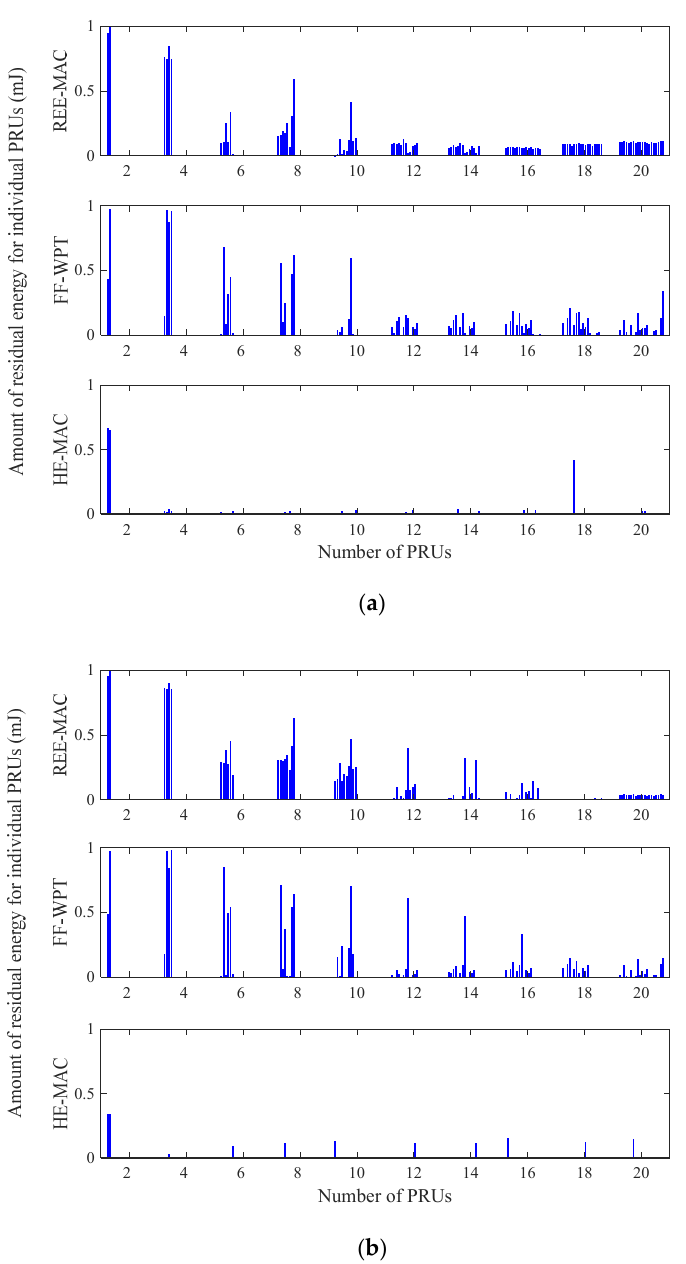
Figure 8. Residual energy distribution of individual PRUs: ( a ) packet size of 100 bytes; ( b ) packet size of 200 bytes.